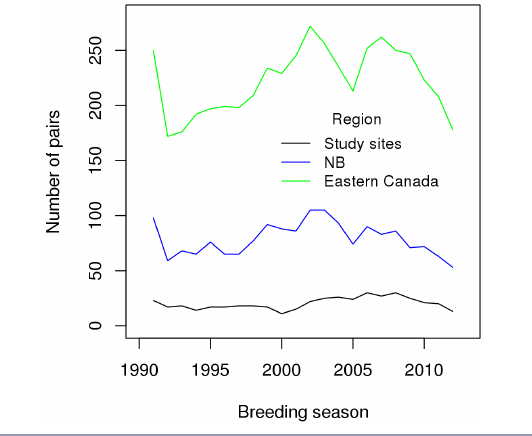
Fig. 7 . Total number of Piping Plover ( Charadrius melodus melodus ) nesting pairs in the study sites compared with numbers in the entire province of New Brunswick (NB) and eastern Canada from 1991 to